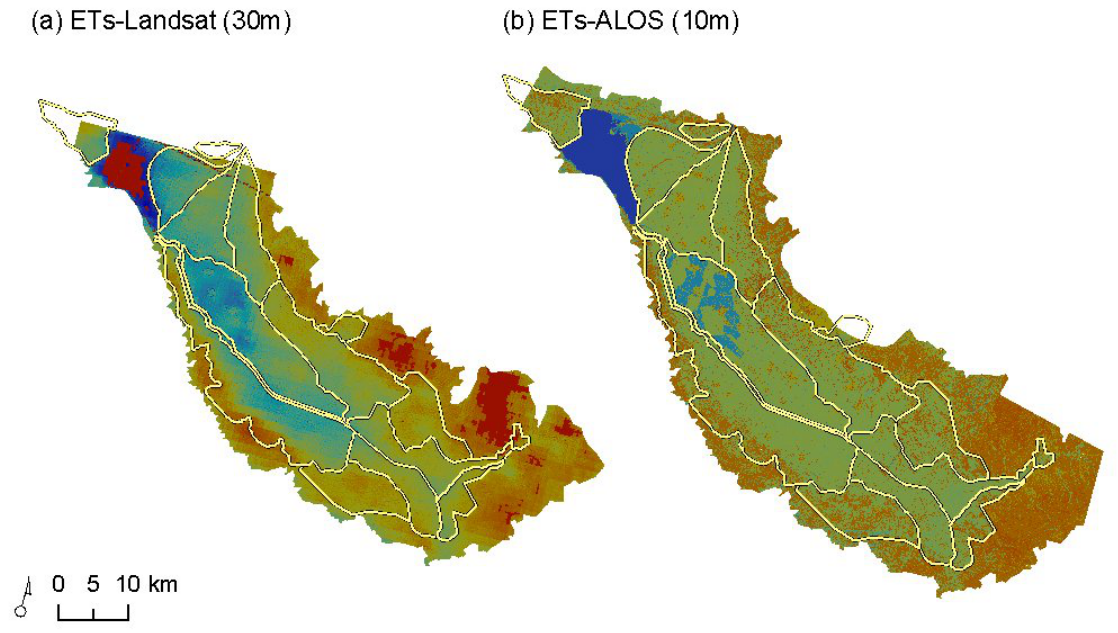
Figure 8. Comparison of ETs-Landsat (a) against ETs-ALOS